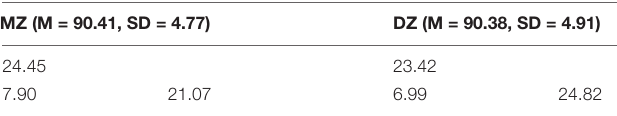
Variance on diagonals and covariance on